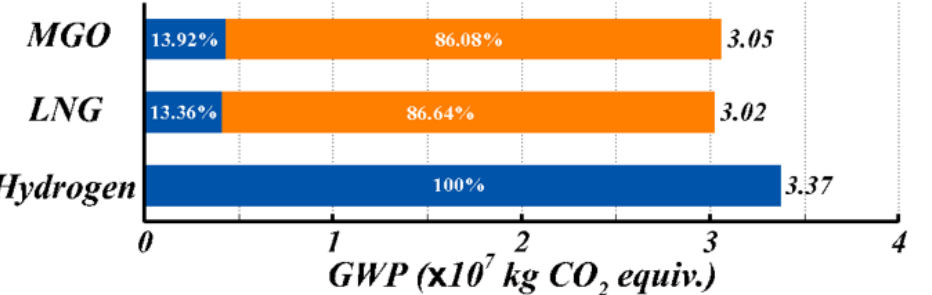
Figure 19. GWP results in the well-to-wake phase.